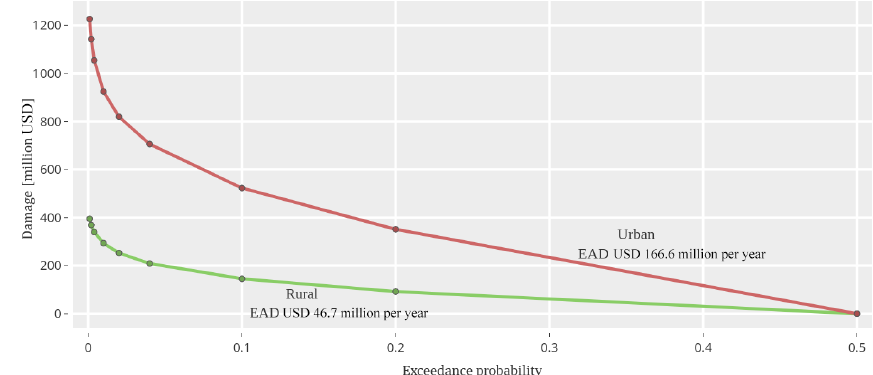
Figure 5. Risk curve for simulated flood damage to building structures in urban and rural areas of Ethiopia for return periods from 2 to 1000 years. USD amounts are given in 2016 values.